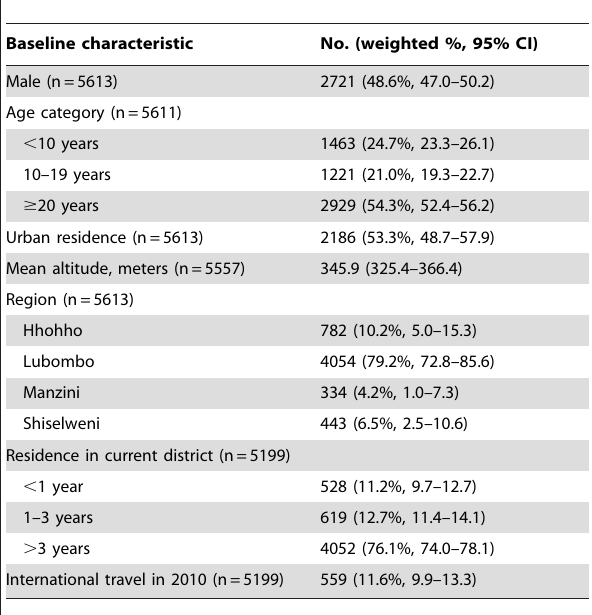
Table 1. Baseline characteristics of survey participants.